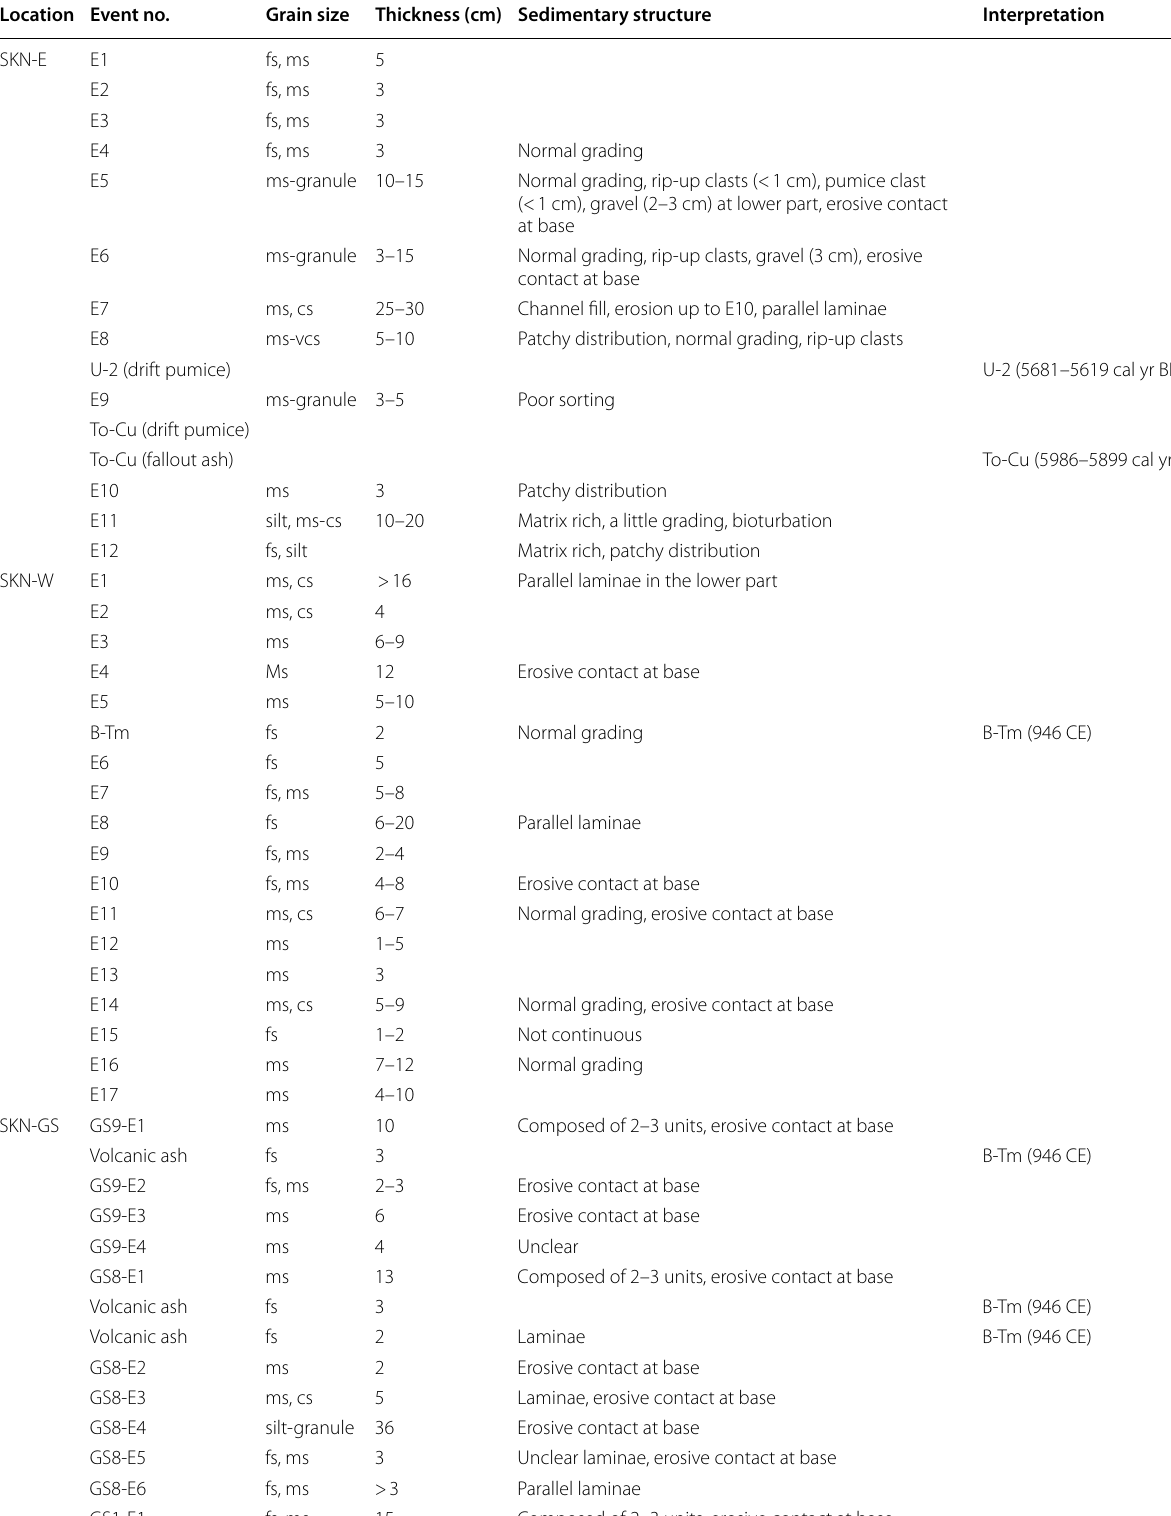
Table 2 Description of sandy event deposits in samples SKN-W, SKN-E, and SKN-GS Location Event